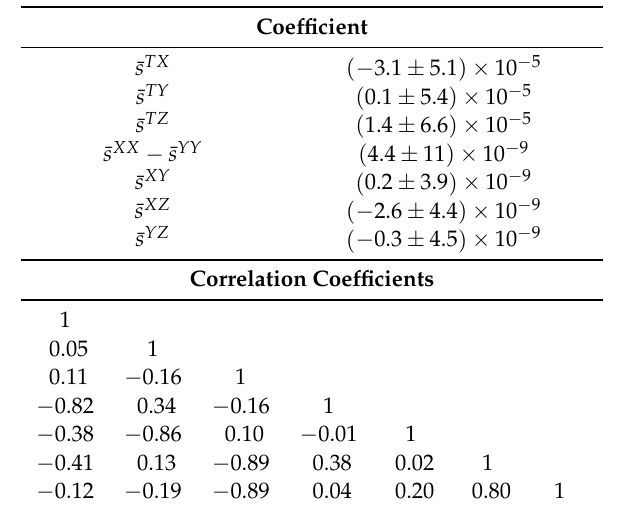
Table 1. Atom-interferometry limits on Lorentz violation in gravity from [48]. The correlation coefficients can be derived from Table III of